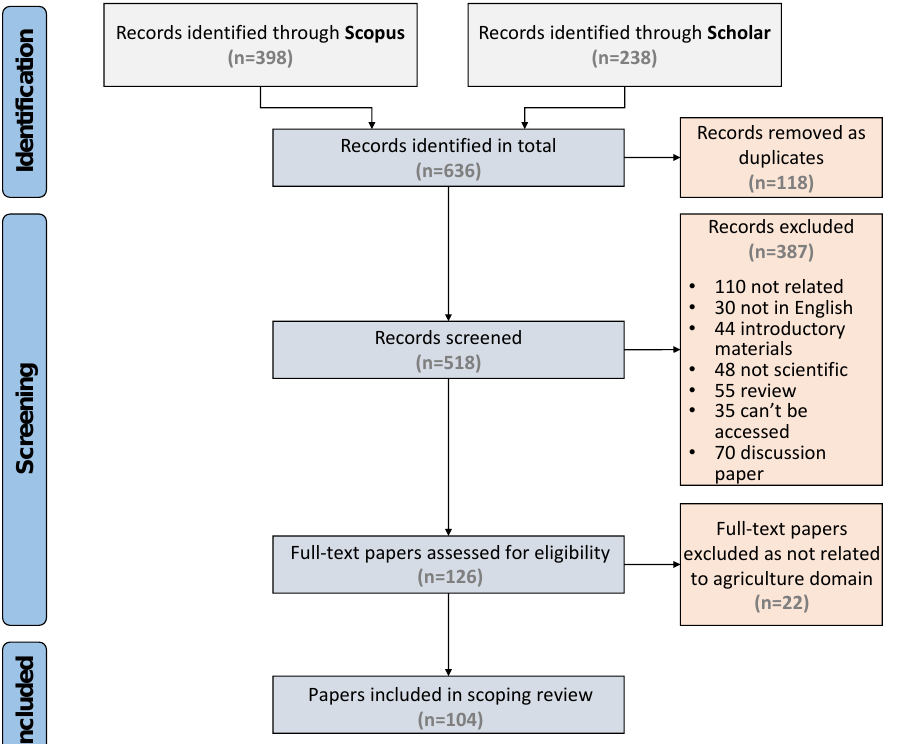
Figure 1. Source selection process from bibliographic search